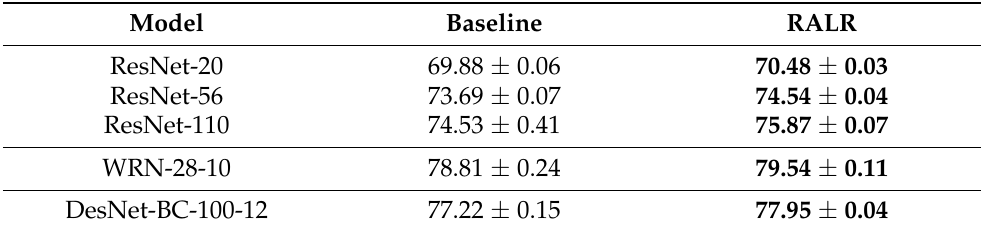
Table 2. Validation accuracy (%) over different architectures on